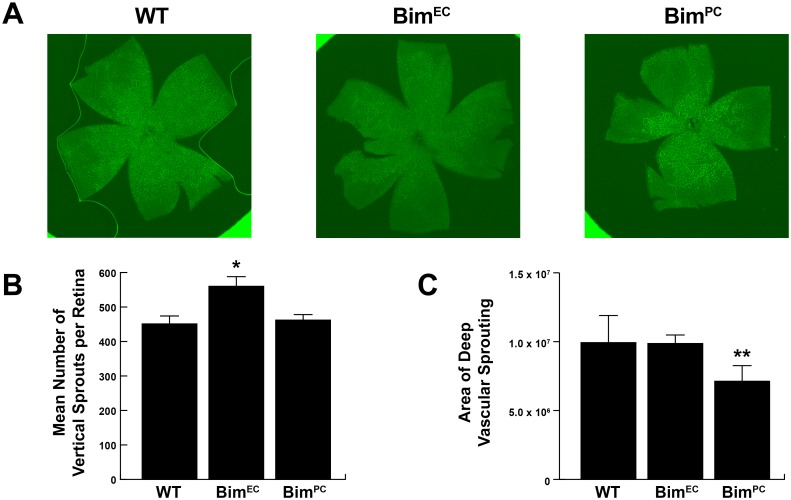
Enhanced deep vascular plexus formation in BimEC mice.In Panel A, retinas from P10 wild-type, BimEC and BimPC mice were wholemount stained with Isolectin B4 and the superficial layer imaged (25x). In Panel B the mean number of vertical sprouts were quantified in each retina. (n = 5, *P<0.05). In Panel C, the area covered by the vertical sprouts for each retina was quantified. (n = 5, **P<0.01)